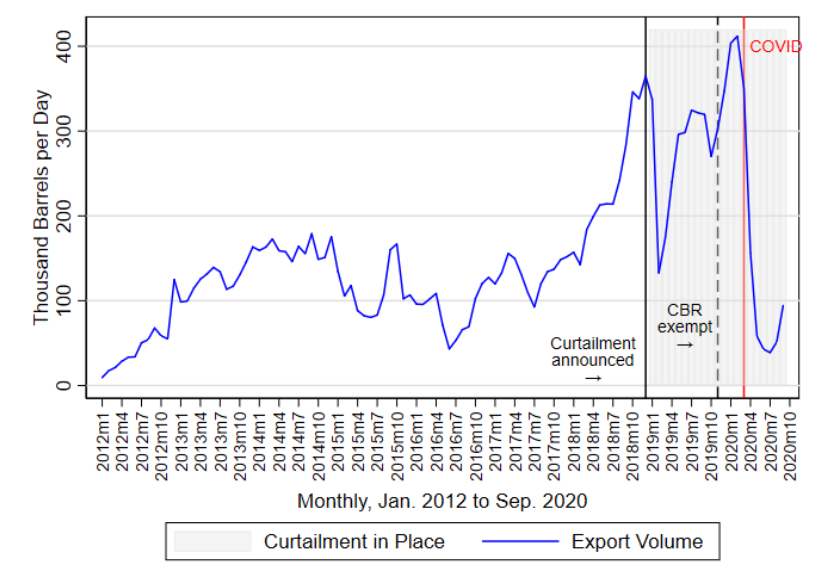
Figure 3. Monthly Crude by Rail (CBR) Exports to the United States, 2012–2020 [20]. Excludes condensate. CBR became exempt from curtailment on 28 October 2019; see Figure 2 for full